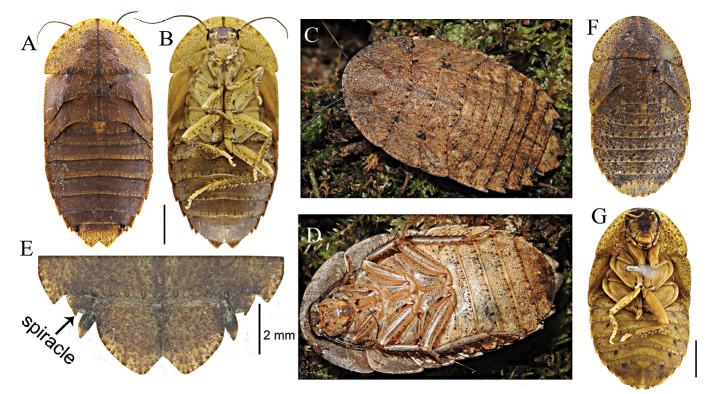
A–BP.kabakovi (nymph) scale bars = 5 mm C–DP.clavellata (nymph) E abdomen of female of P.clavellataF–GBrephallusfruhstorferi (Shelford, 1910) comb. nov. (nymph).